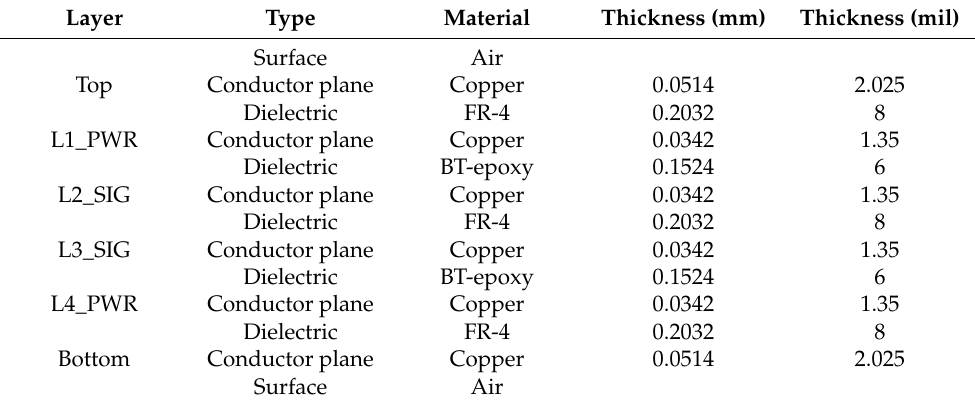
Figure 7. RABE-printed circuit board. A 3D model of the RABE (( a ) top layer and ( b ) bottom layer). Within the PCB, it is intended to integrate devices with the ability that they can be selected (RF switch) and digitally tuned [16] to take advantage of the available space in it and to be able to use different devices such as antennas, amplifiers, and filters in frequency bands that are too far apart from the main one. Table 3. RABE PCB